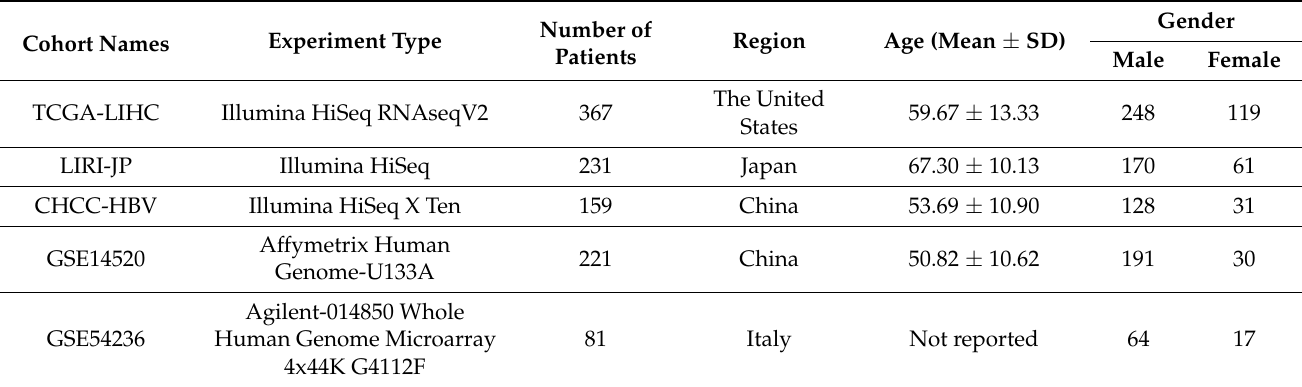
Table 1. Demographical features of the HCC cohorts used in this